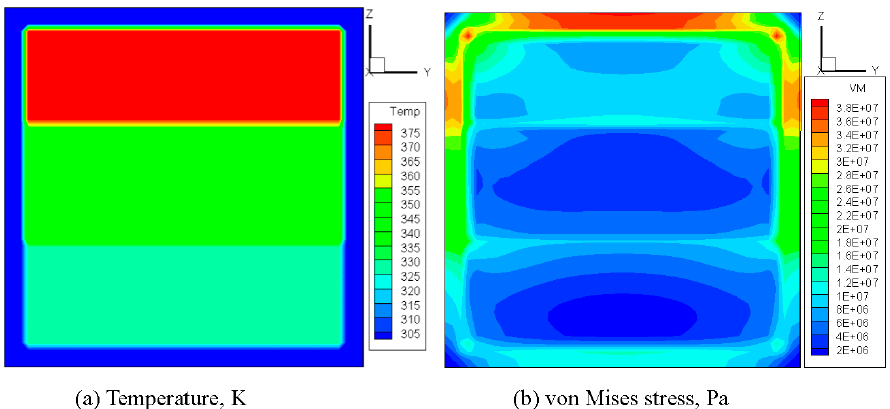
Figure 2. Distributions of temperature and von Mises stress in the glass before crack initiation. ( a ) Temperature distribution in glazing; ( b ) Von Mises Stress. (“3.8E+07” represents “3.8 × 10 7 ” in legend).